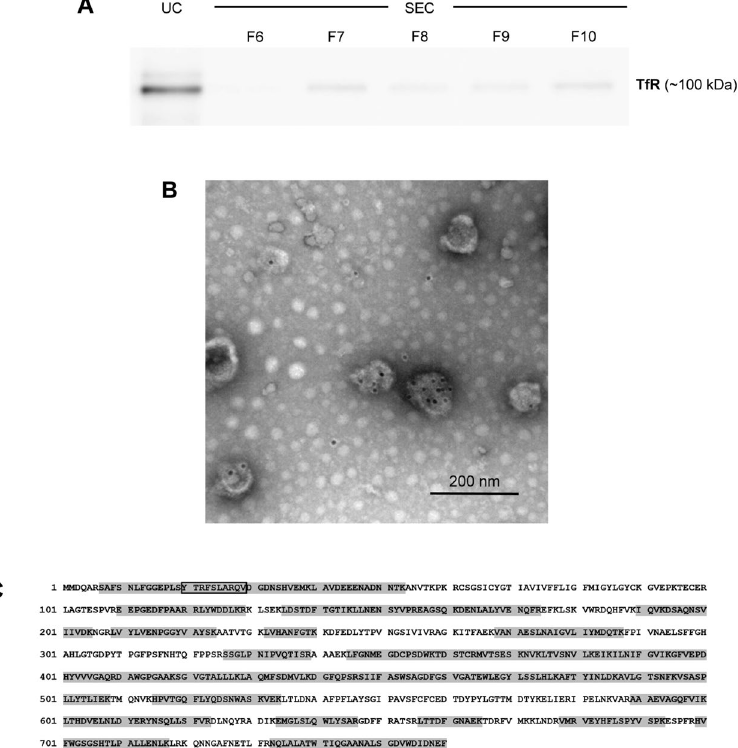
Figure 2. Detection of the transferrin receptor (TfR) in human reticulocyte-derived exosomes. ( A ) Immunoblot in HuRex purified by UC and SEC fractions. (B) Immunogold labelling of UC- HuRex using a secondary antibody conjugated to 10 nm-gold spheres. Scale bar represents 200 nm. (C) Protein coverage by unique peptides (grey boxes) identified by MS. The peptide sequence YTRFSLARQV, corresponding to the binding domain of TfR for hsc71 42 , is boxed in black. UniProtKB – P02786 TfR sequence is